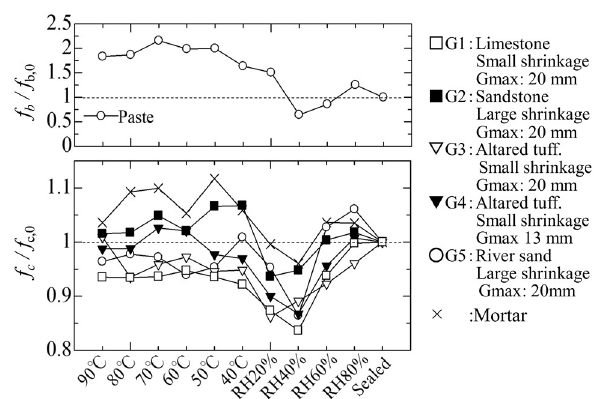
Figure 6. Change in bending strength of hardened cement paste (top) and compressive strength of mortar and concretes (bottom) after